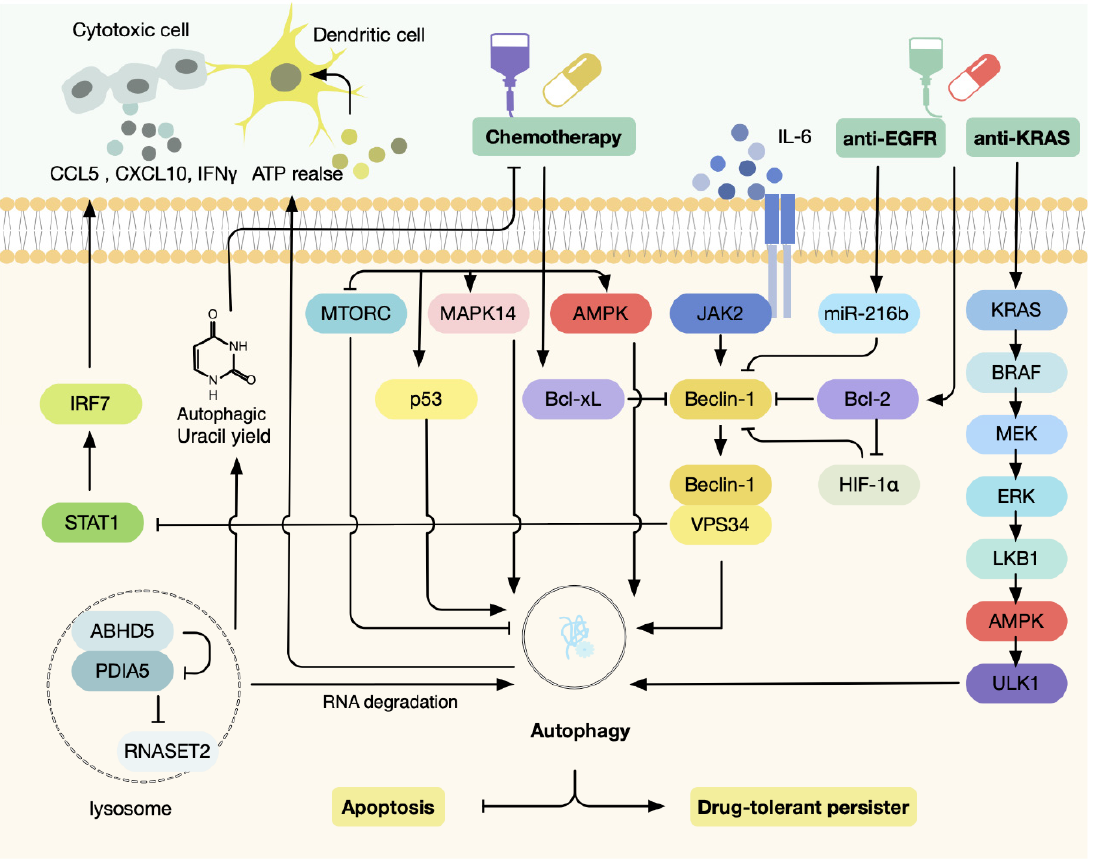
Figure 6. Autophagy under therapeutic stress in CRC. Autophagy activation has been observed during chemotherapies, targeted therapies, and PDT against CRC. In most cases, autophagy serves as a survival mechanism by protecting cells from apoptosis or maintaining cell survival in a DTP state; therefore, autophagy inhibition may be an effective therapeutic strategy in CRC. Paradoxi- cally, autophagy is indispensable in the immune response to chemotherapy in CRC; hence, suppres- sion of autophagy may result in a reduction of immunogenicity of cancer cells and impair antitumor tional therapies warrants further